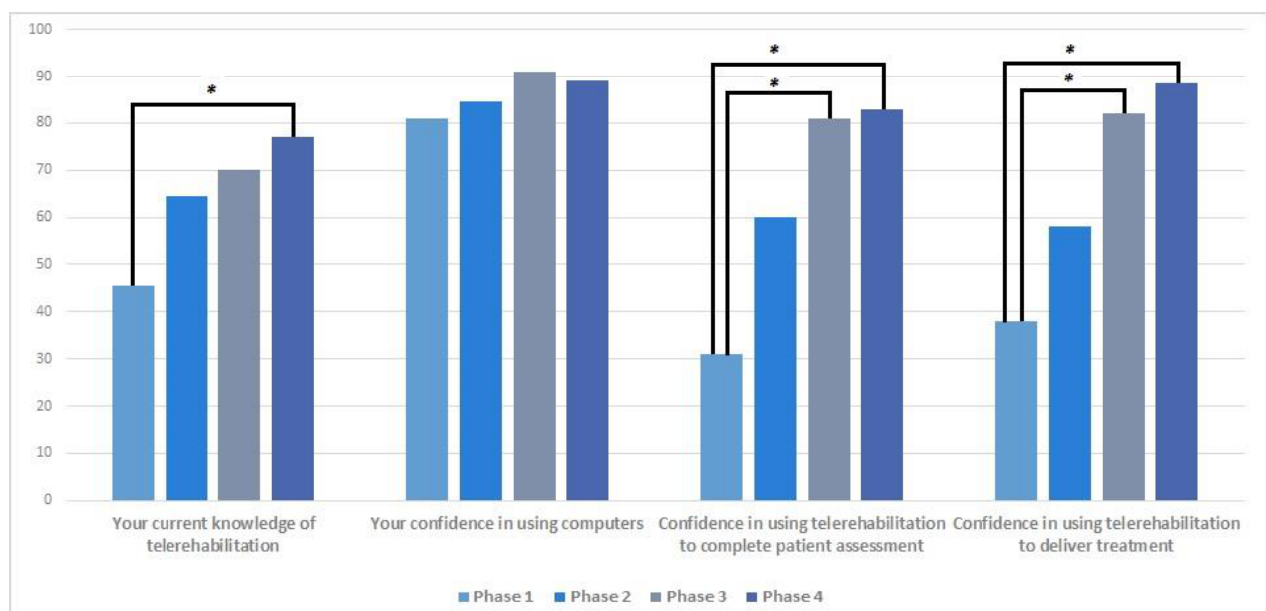
Figure 1. Participants’ change in knowledge and confidence towards